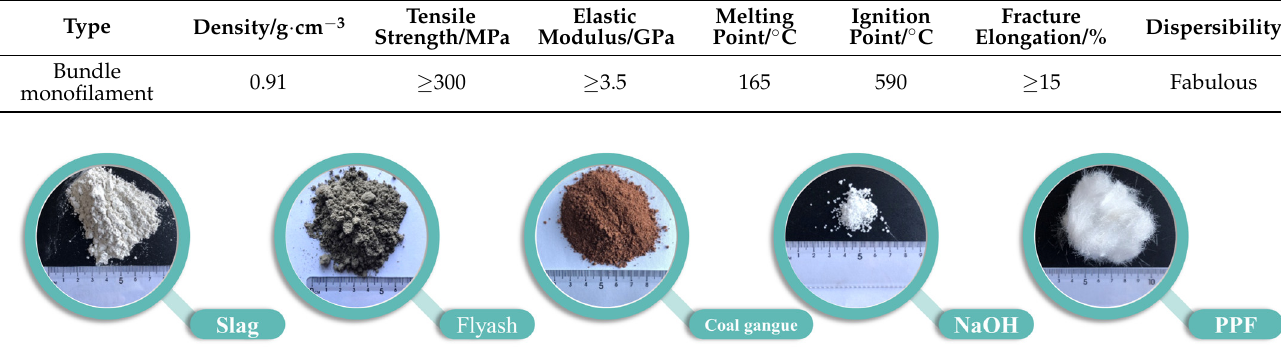
Figure 3. Particle size curve of slag and fly ash. Table 5. Physical properties of polypropylene fibers.